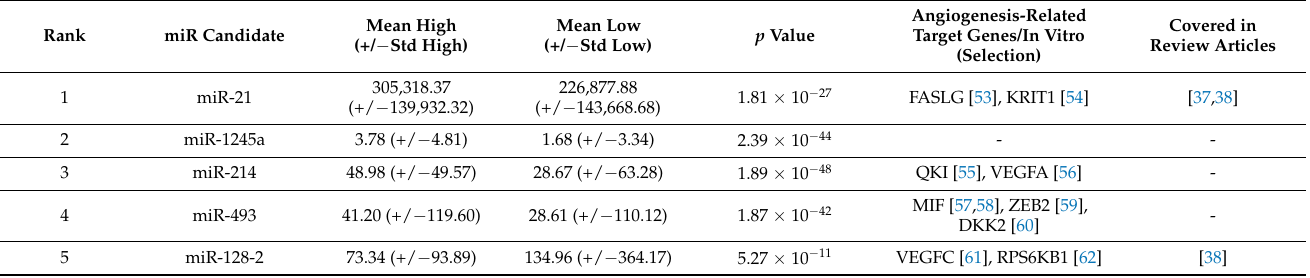
Table 2. MicroRNAs (miRs) predicted to best discriminate FAP high- vs. low-expressing tumor samples. p values significant for p < 0.01 are highlighted in